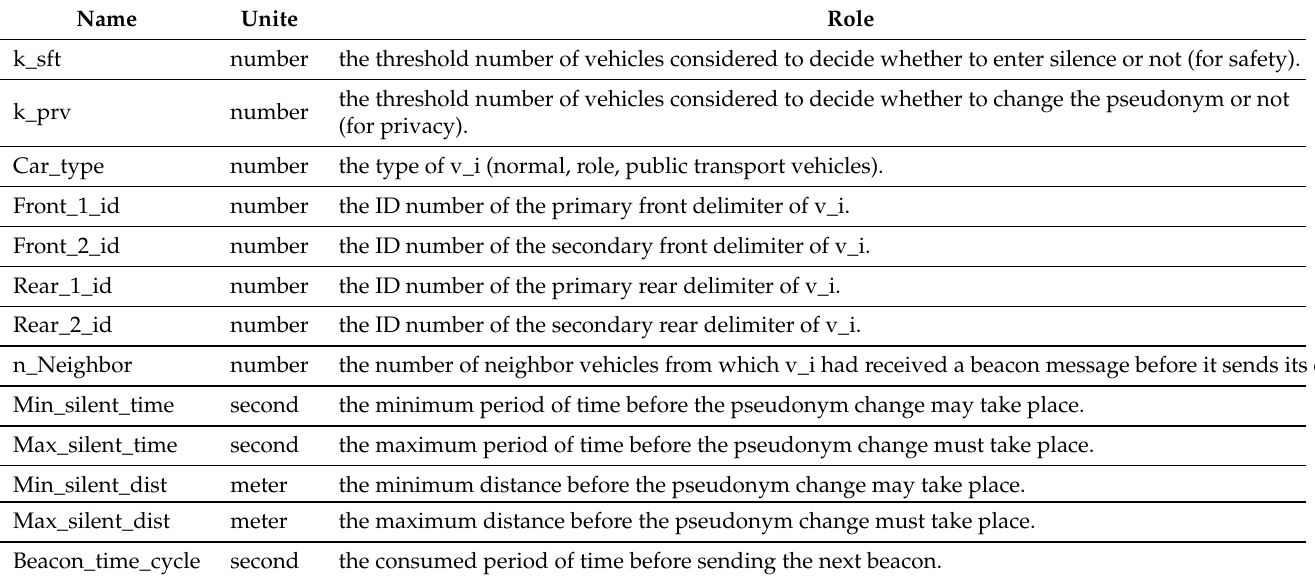
Table 2. The used terminologies in OVR for the integer variables.